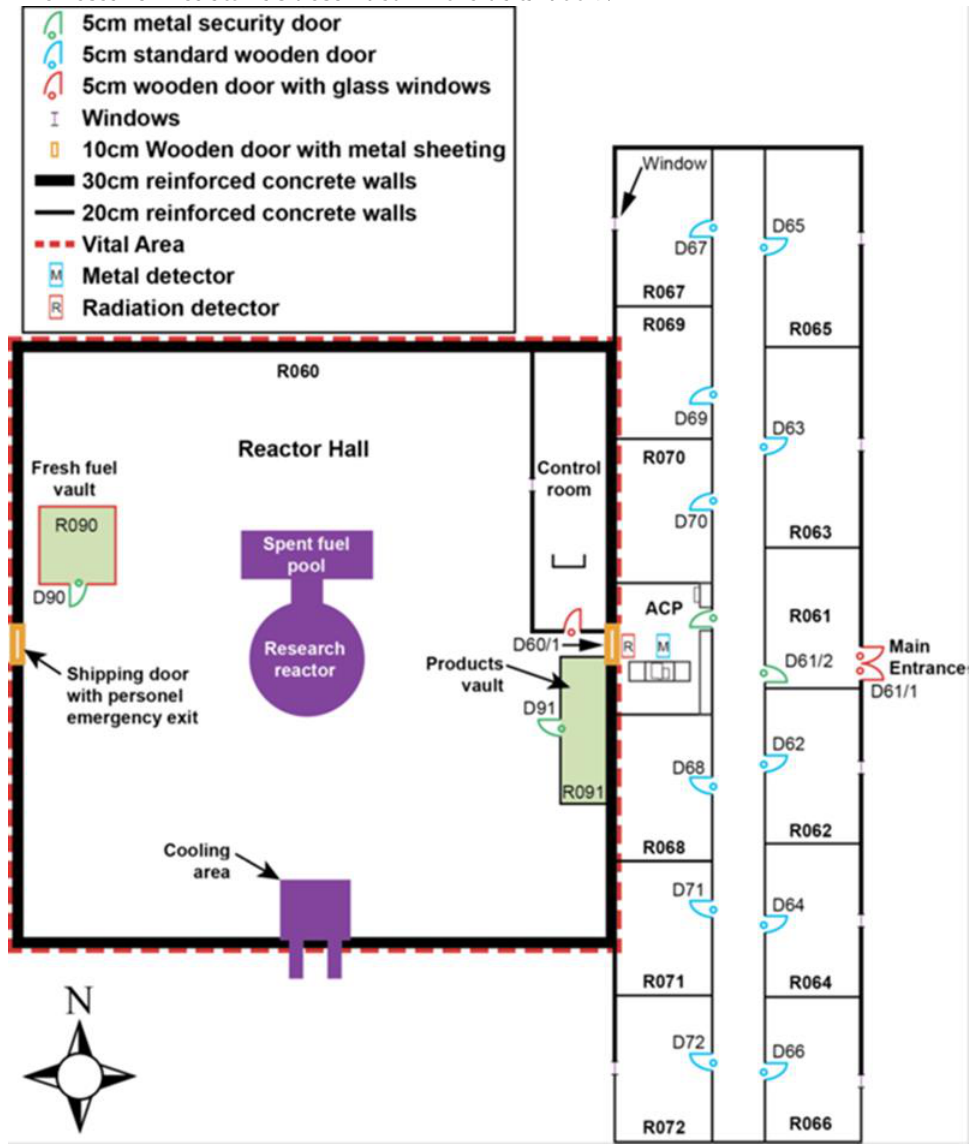
Figure 3: Research Reactor Building Floor